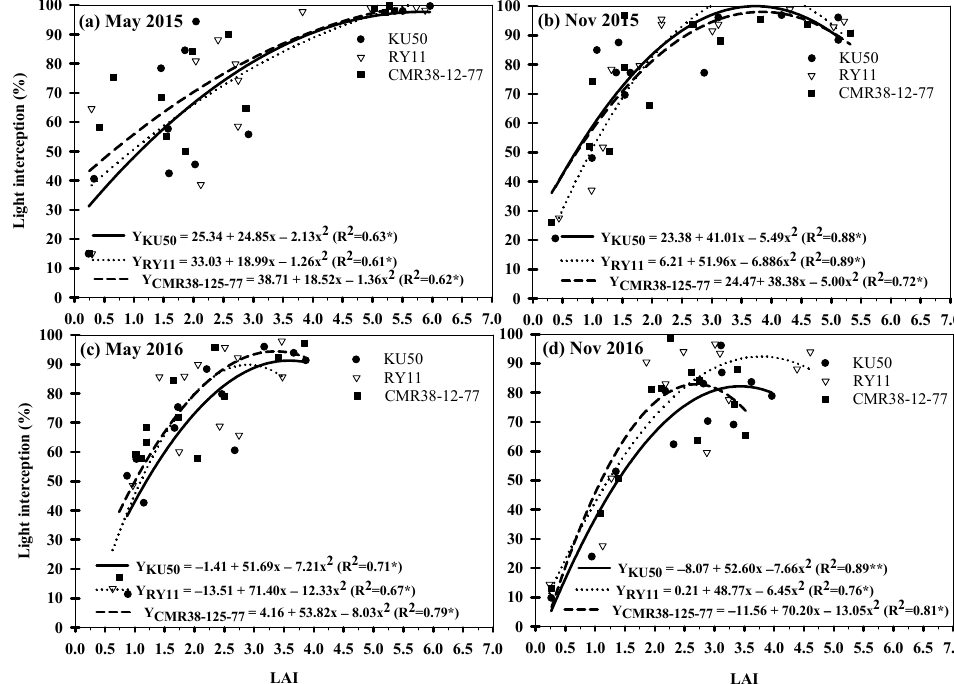
Figure 3. Regression analysis for LAI and light interception (%) of 3 cassava genotypes planted in May and November 2015 ( a , b ) and 2016 ( c , d ). *, ** = significant at p < 0.05 and p < 0.01 probability levels, respectively. (Figure 4d).